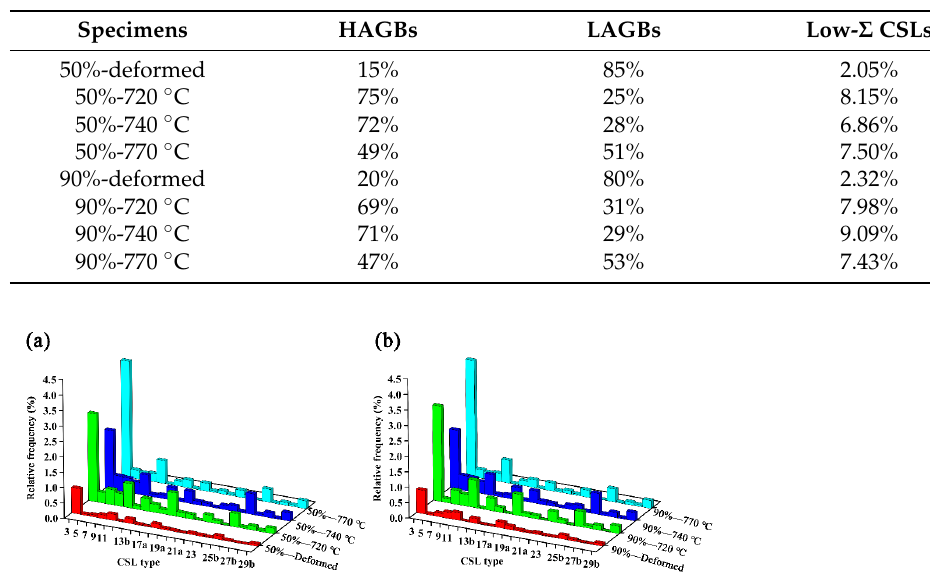
Figure 12. Low- Σ CSL boundary distributions of X2CrNi12 steel at 50% deformation ( a ) and 90% deformation ( b ) with different annealing temperatures. Table 2. Grain boundary distribution of X2CrNi12 steel specimens.